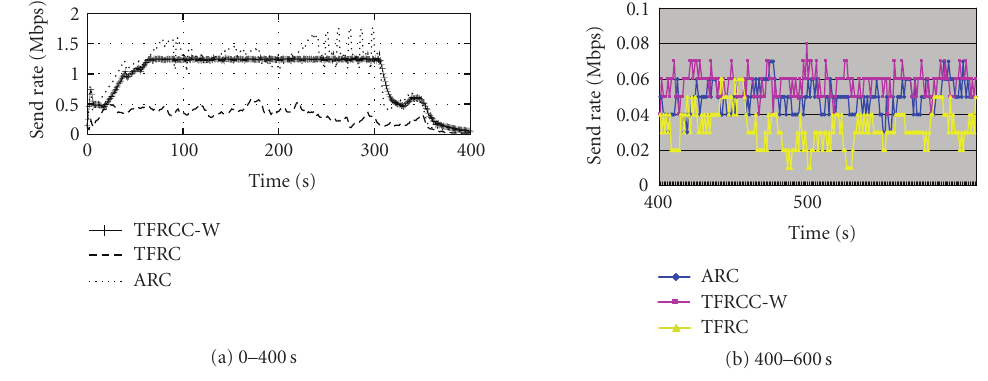
Figure 8: The sending rate of one GM-TFRC flow, one GM-ARC flow, and one VB-TFRCC-W flow.